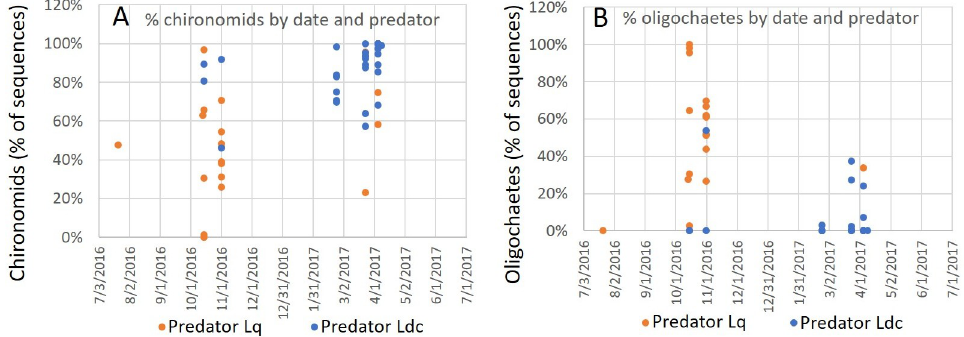
Fig 8. Seasonal distribution of water mite species and the percent abundances of sequences of (A) chironomid and (B) oligochaete in 20 L . quinquemaculosa (Lq, orange points) and 29 L . davidcooki (Ldc, blue points). Some points are not visible where others are superimposed on them. Differences over time analyzed by the seasonal Mann-Kendall test for trend were significant for oligochaetes in L . quinquemaculosa (p = 0.031) but not for other comparisons. In (A) L . davidcooki had a higher percentage of chironomid sequences than L . quinquemaculosa (Yuen’s test, p = 0.00001). In (B), L . quinquemaculosa had a higher percentage of oligochaete sequences than L . davidcooki (Yuen’s test, p = 0.0002).